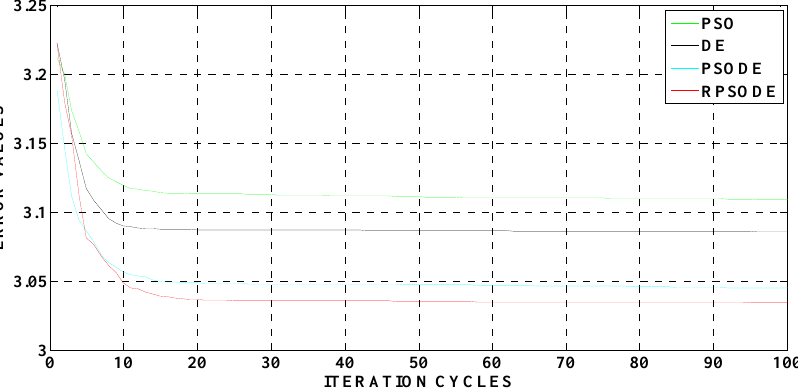
Figure 5. Comparison of convergence profiles for PSO, DE, PSODE and RPSODE of HP filter of order